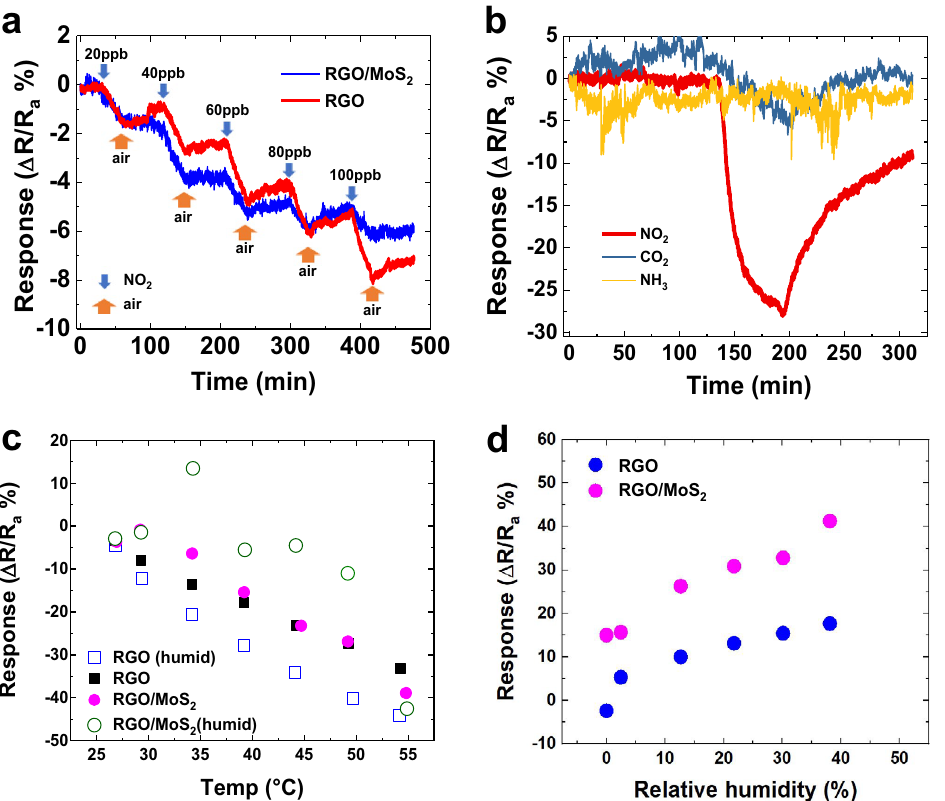
Figure 3. Textile gas sensing. ( a ) Response of fabricated sensors to increasing NO 2 concentrations in dry air from 20 to 100 ppb for RGO-coated fabric and RGO/MoS 2 -coated fabric respectively. Both sensors show little recovery in dry air. ( b ) Gas sensing response of the RGO/MoS 2 -coated fabric to NO 2 , NH 3 and CO 2 showing selectivity of the coated material to NO 2 . ( c ) Variation in response of the RGO and RGO/MoS 2 -coated fabric due to increasing temperature at a fixed concentration of 100 ppb NO 2 both in dry air and humid air respectively. ( d ) Variation in response of the RGO and RGO/MoS 2 -coated fabric due to increasing humidity at a fixed concentration of 100 ppb NO 2 helps determine the humidity correction